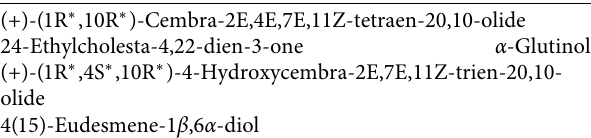
Table 3: Diterpenoids (6 cembranolides) [36].